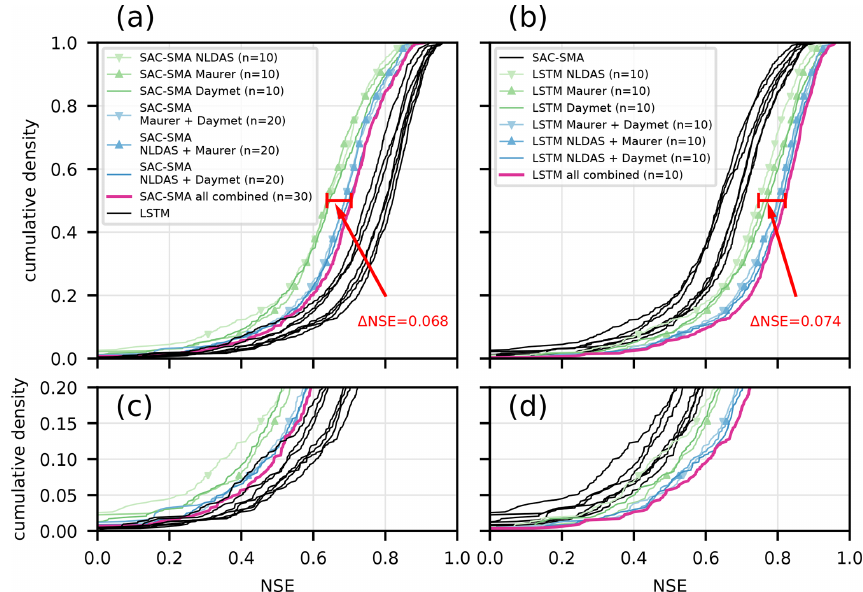
Figure 4. Empirical cumulative density function of the NSE performance over the 531 basins of different SAC-SMA ensembles (a, c) and different LSTM ensembles (b, d) . Panels (a, b) show the entire range of the cumulative density function, while panels (c, d) show the lower range in more detail. The red indicator lines mark the median NSE difference between the worst single-forcing ensemble and the multi-forcing ensemble of the LSTM and SAC-SMA, respectively.